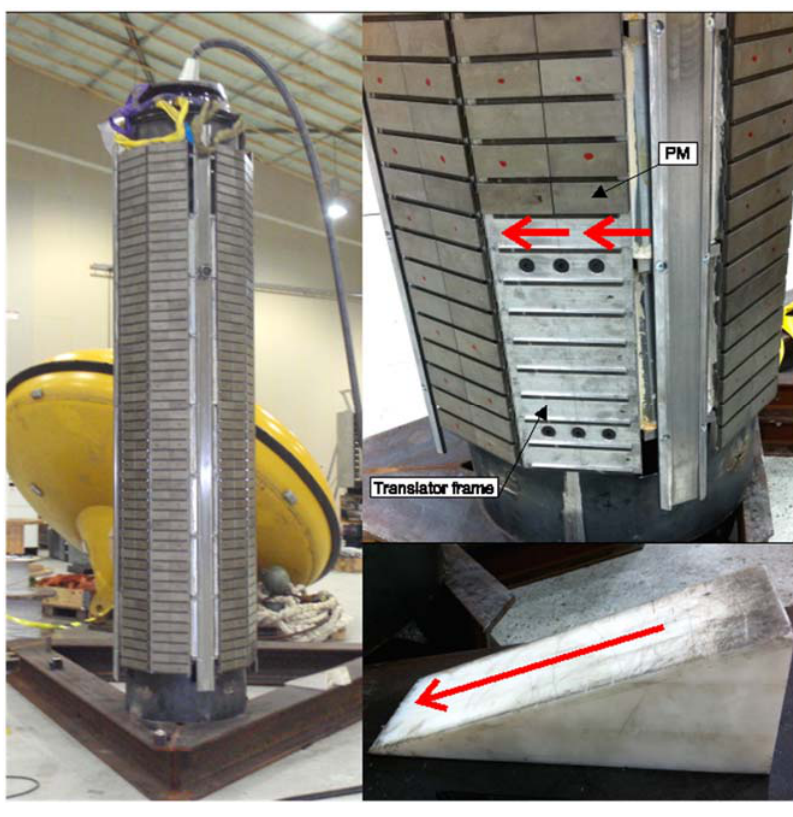
Figure 1. The Uppsala University (UU) wave energy converter (WEC) generator translator design. ( Left ) The complete translator; ( Top right ) a translator close-up and ( Bottom right ) the plastic wedge manual permanent magnet (PM) mounting tool. The red arrow on the plastic wedge shows how the PMs are slid off the wedge using a rubber hammer during manual assembly, and the red arrows on the translator frame show the assembly position and direction for the next two